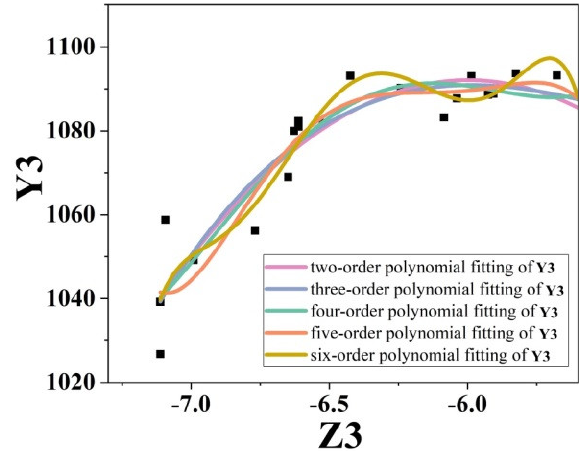
Figure 4. Five different polynomial fitting curves for RPM(Z) and EGT3(Y3).